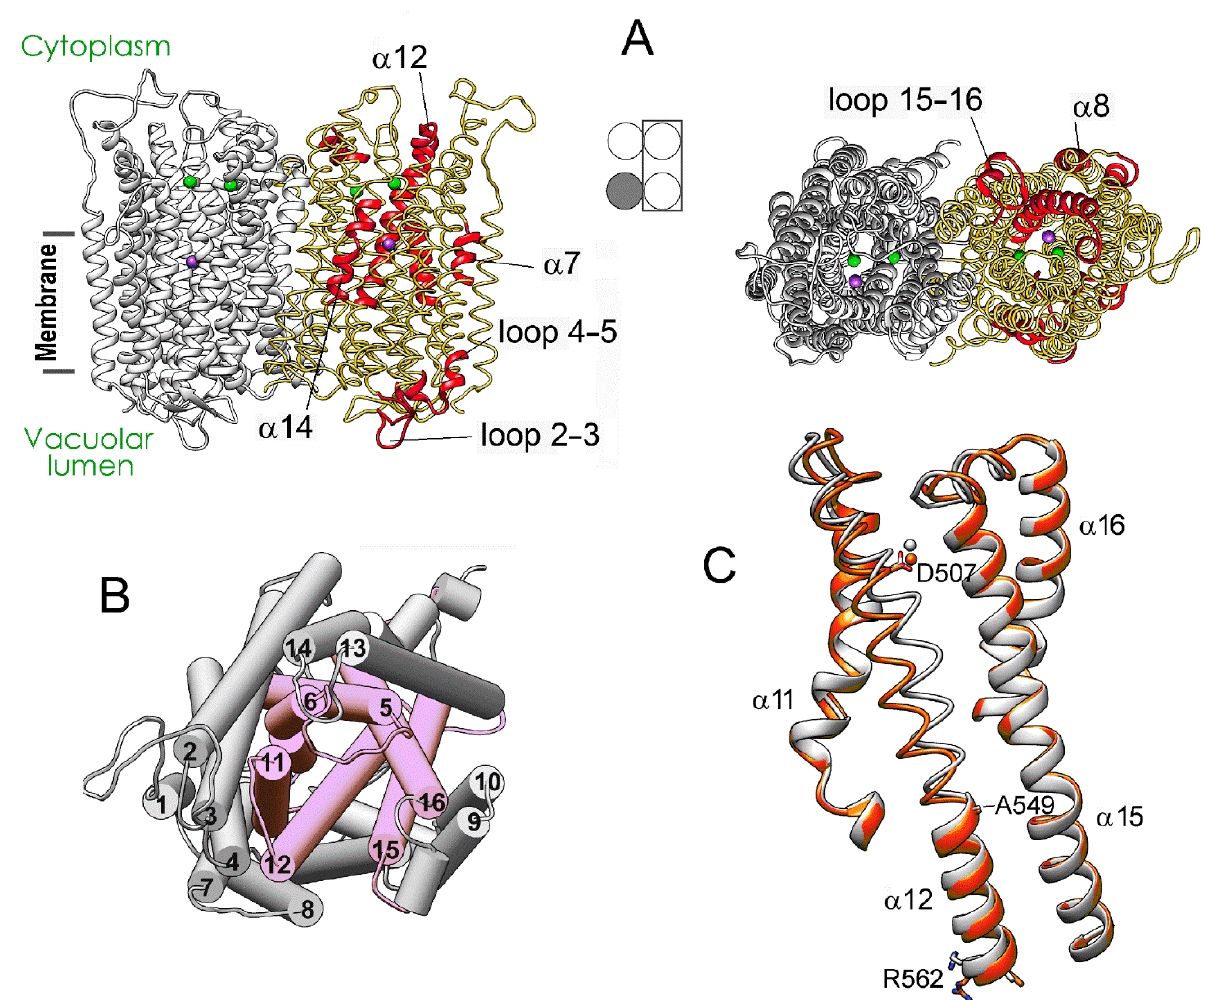
Figure 3. Structure changes in a subunit of the resting Vr-mPPase dimer upon IDP binding to the neighboring subunit. ( A ) The structure of the resting dimer showing the regions (colored red in one subunit) that will undergo the most significant displacements upon IDP binding to the other subunit. Subunit occupancy with IDP in the dimers compared is indicated in the middle scheme, like in Figure 2. Two bound Mg 2+ and one K + ions are shown as green and magenta spheres, respectively. ( B ) The same view on the cytoplasmic side of the left-side subunit as on the right part of panel A , but the helices are shown as cylinders and numbered according to Figure 2. The six helices forming the inner ring are pink. ( C ) Bending of α 12 in subunit B upon IDP binding to subunit A of mPPase dimer. The panel shows a part of the superposition of the IDP-free subunits from the resting and IDP-bound dimers (grey and red, respectively) used to identify the regions marked red in panel A . Bound Mg 2+ ion is shown as a sphere of the same color. This comparison corresponds to Figure 2D. The molecule was rotated by approximately 180° compared to the view in ( A ).